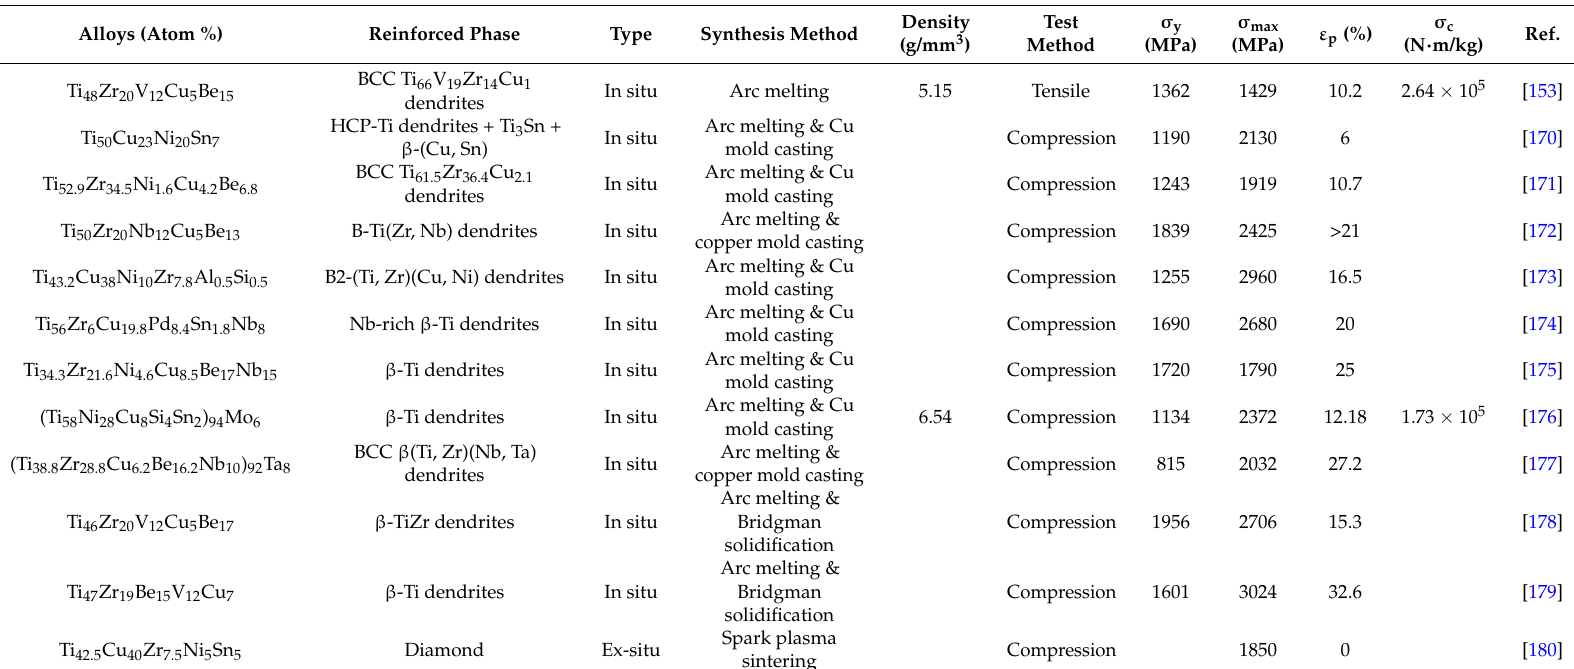
Table 5. A brief summary of Ti-based bulk metallic glass composites